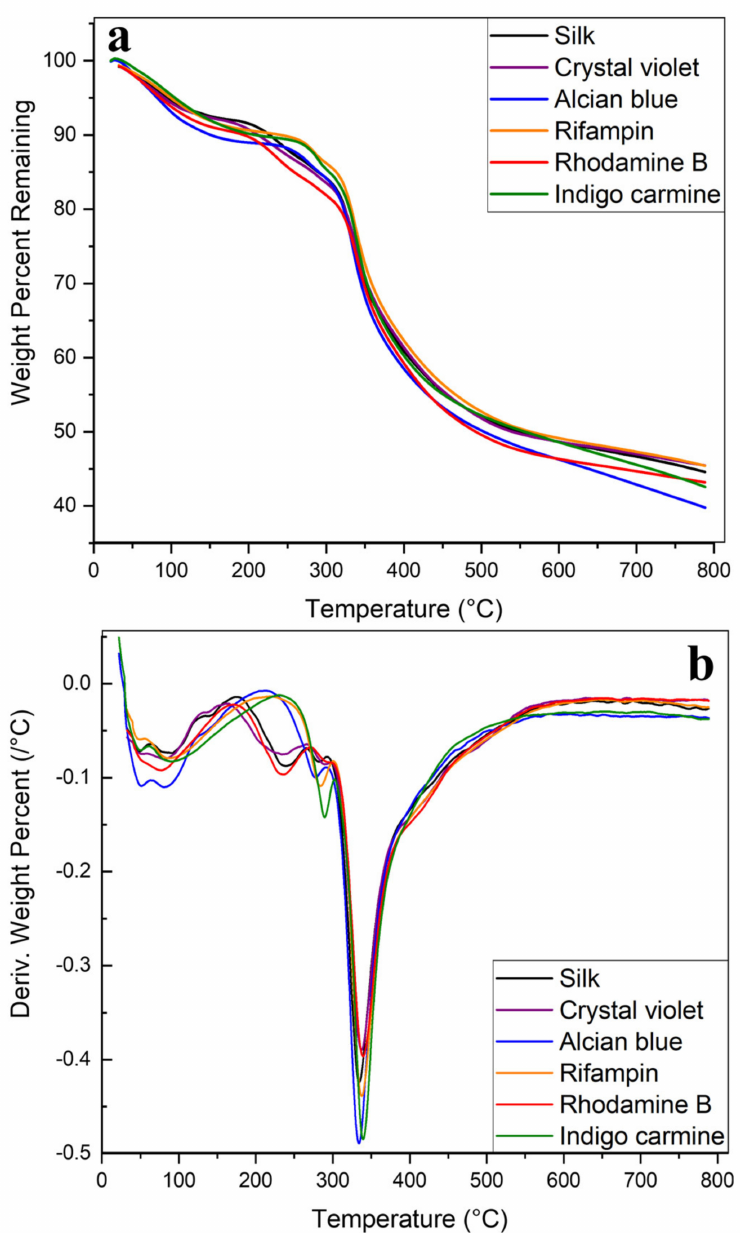
Figure 3. TGA thermograms of silk and silk-model drug air-spun fibers. ( a ) Remaining weight percent of silk and silk-model drug fibers as they were heated to 800 ◦ C. ( b ) Derivative of remaining weight percentage